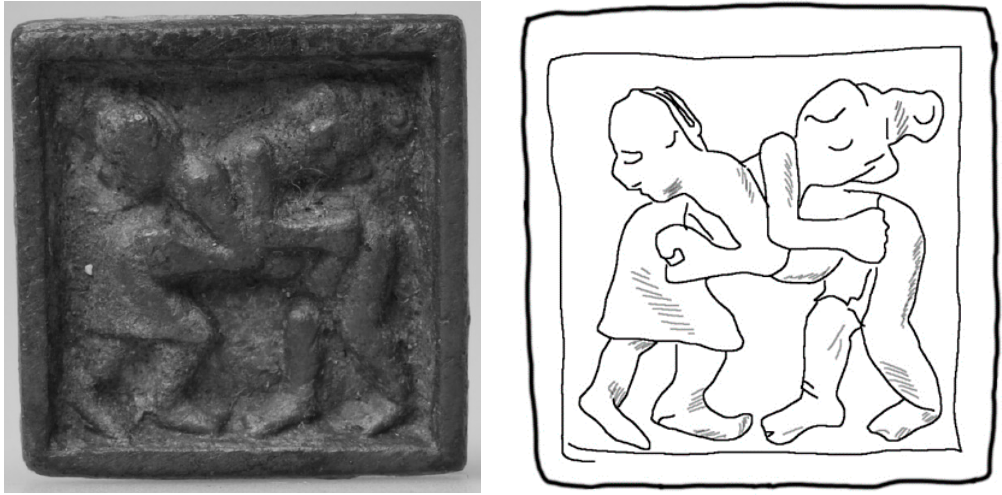
Figure 23. A Song Yuan Huaya with the depiction of Mongolian Bukh. The period of the Song and Yuan Dynasties. Inventory number: HKU.m.61.899. Sketched by author. Copyright © the database of